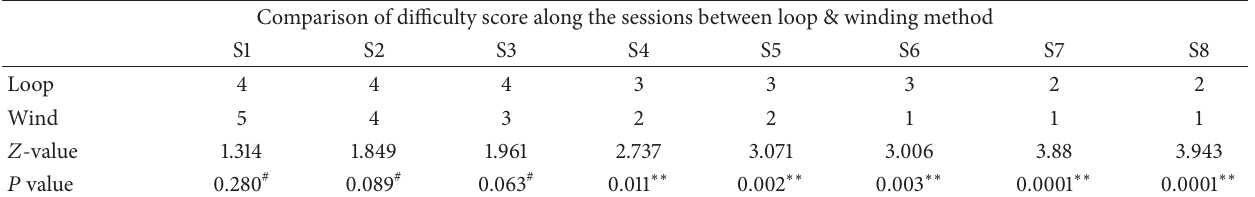
Table 4: Comparison of difficulty level at the end of every session was done between groups A and B (from 1, least difficult level, to 5, highest difficult level).